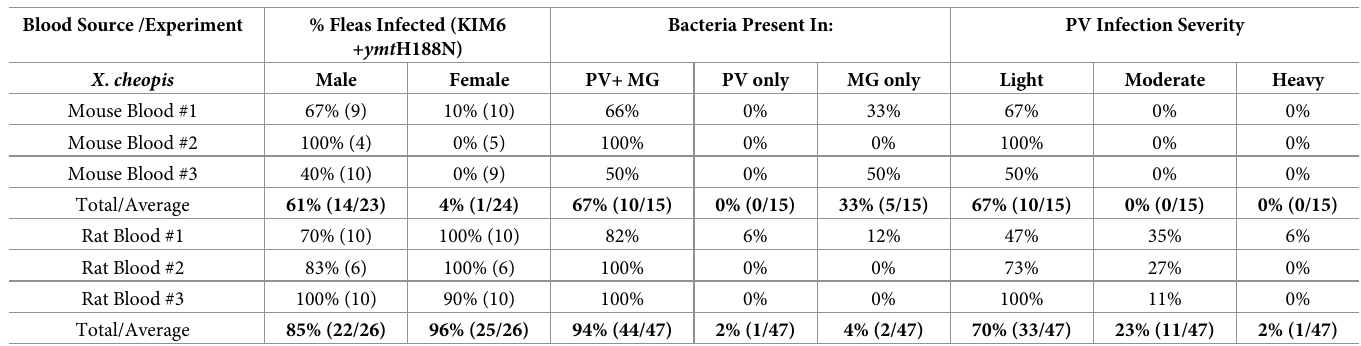
Table 1. Flea Dissection